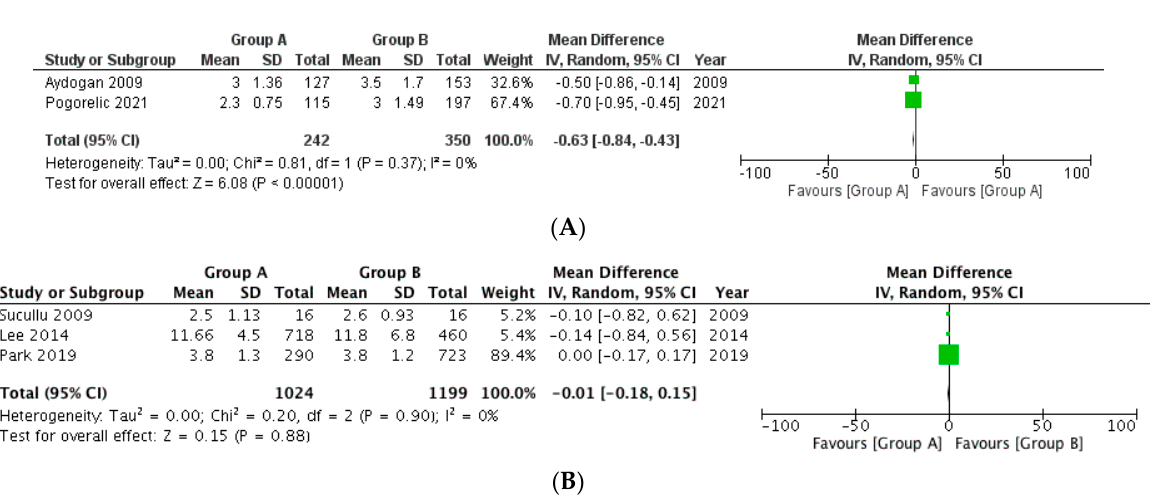
Figure 5. Forest plot comparison between the two patient groups (group A included cases wherein an energy device was used while group B included patients in whom suture or Endoclip or Hem-o-lok ® was used) in terms of the average hospital stay (days). Figure 5A, B depict the outcome comparison with respect to appendicular base ligation and mesoappendix division, respectively. Abbreviations: SD, standard deviation; IV, inverse variance method; CI, confidence interval.